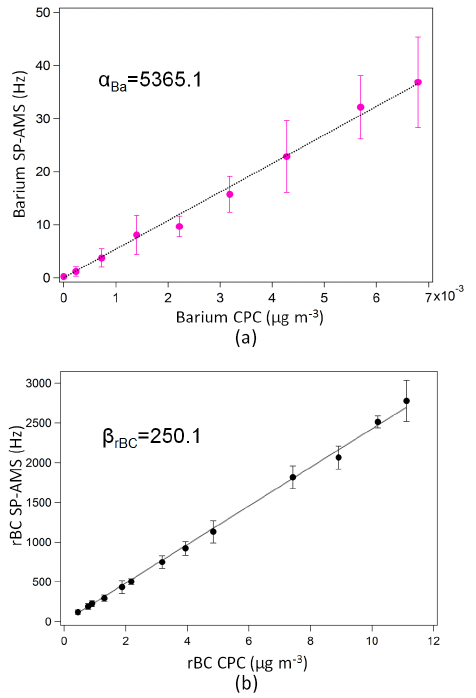
Figure 4. Signal measured by the SP-AMS (Hz) versus the mass concentration obtained by the CPC (µgm − 3 ) for barium (a) and rBC (b)